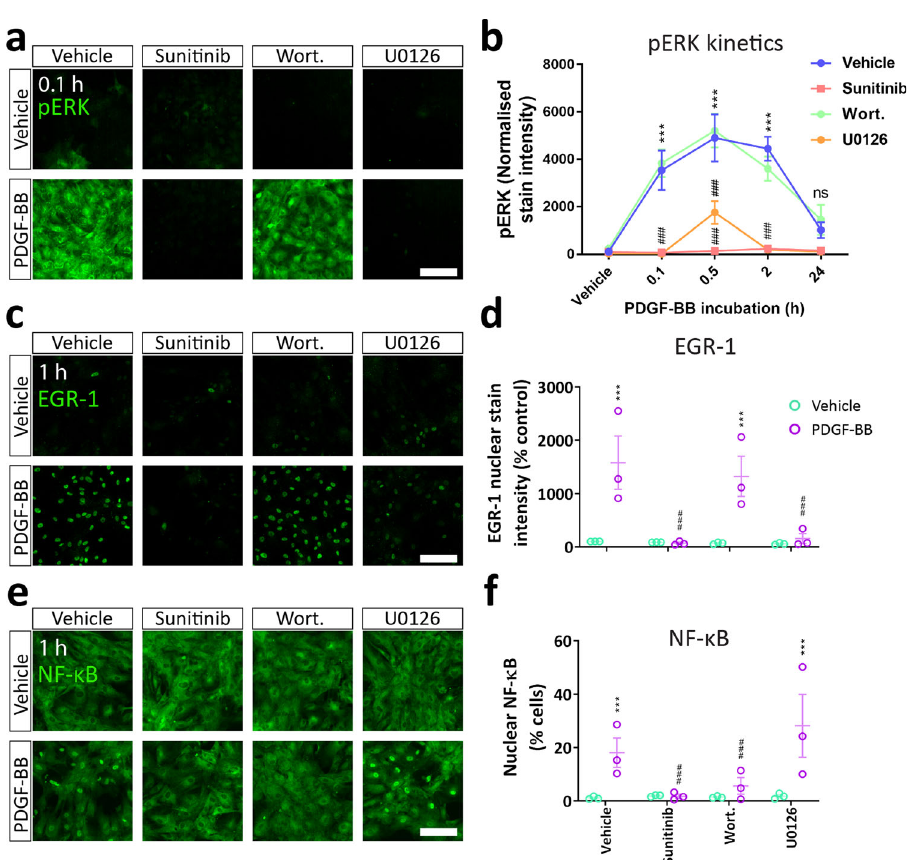
Fig. 6 PDGF-BB activates Akt-dependent NF- κ B and ERK-dependent EGR-1 signalling in pericytes. Pericytes were pre-treated with sunitinib (100 nM), wortmannin (100 nM) or U0126 (10 μ M) or vehicle (0.3% DMSO) for 30 min, then treated with vehicle or PDGF-BB (10 ng/mL) for the speci fi ed timepoints. Cells were fi xed at endpoint and immunostained. Representative images and quanti fi cation of a – b pERK, c – d EGR-1 and e – f NF- κ B activation following PDGF-BB treatment with or without pathway inhibitors. n = 3, two-way ANOVA. Scale bar = 100 μ m. * p < 0.05, ** p < 0.01, *** p < 0.001 vs vehicle control, # p < 0.05, ## p < 0.01, ### p < 0.001 vs